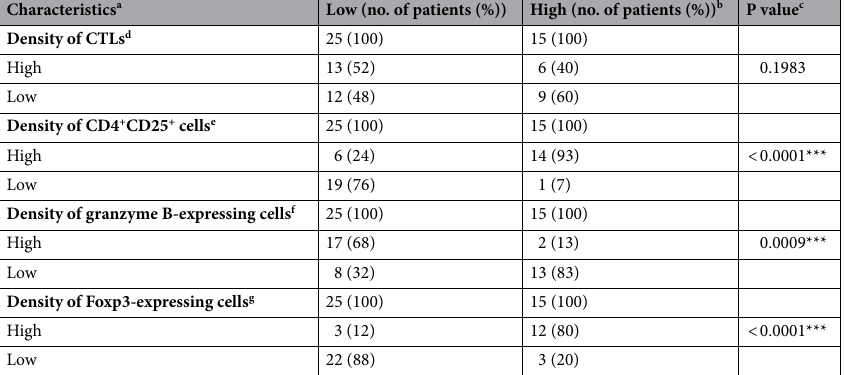
Table 2. Clinicopathological correlation of the percentage of pre-S2 plus pre-S1 + pre-S2 deletion in 40 HBV- related HCC patients. HBV hepatitis B virus, HCC hepatocellular carcinoma, CTLs cytotoxic T lymphocytes, Foxp3 forkhead box P3, HBeAg hepatitis B e antigen, AST aspartate aminotransferase, ALT alanine aminotransferase, AFP alpha-fetoprotein, CLIP Cancer of the Liver Italian Program, BCLC Barcelona